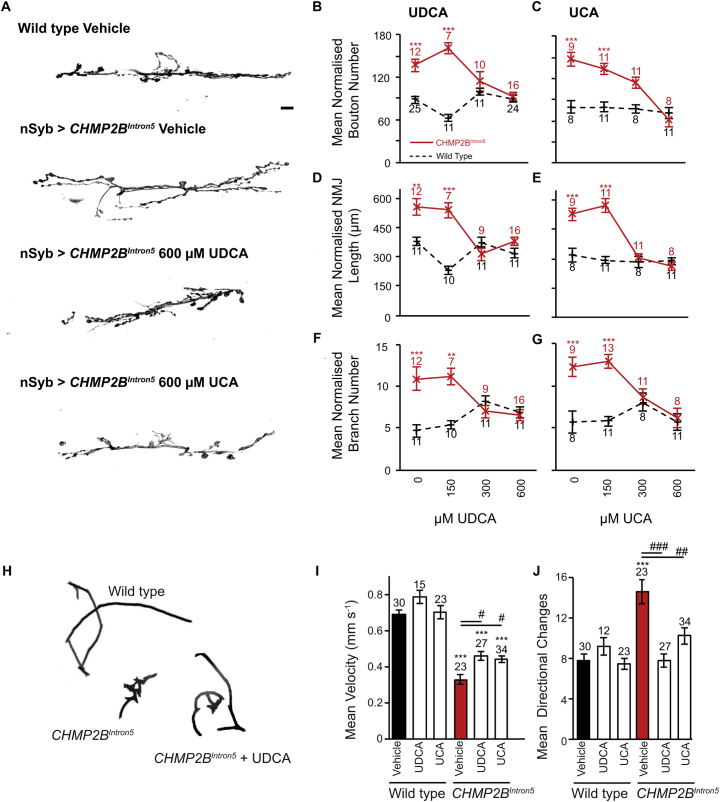
UDCA and UCA Exhibit a Dose Dependent Rescue of Synaptic Overgrowth at the Drosophila NMJ.A. Representative micrographs showing synaptic overgrowth at the Drosophila third instar wandering larval NMJ (Muscle 6/7, hemisegment A3) in larvae pan-neuronally expressing (nSyb-Gal4) UAS-CHMP2BIntron5 administered vehicle, UDCA or UCA. Scale bar = 10 μm.B—C. Quantification of normalised bouton number in wild type (dashed black line) and CHMP2BIntron5 expressing (nSyb-Gal4) (solid red line) 3rd instar larvae in response to increasing doses of UDCA (B) and UCA (C). ANOVA with post-hoc Tukey comparison to vehicle treated (0 μM) control ⁎⁎⁎p < .001.D, E. Quantification of normalised NMJ length in wild type (dashed black line) and CHMP2BIntron5 expressing (nSyb-Gal4) (solid red line) 3rd instar larvae in response to increasing doses of UDCA (D) and UCA (E). ANOVA with post-hoc Tukey comparison to vehicle treated (0 μM) control ⁎⁎p < .01, ⁎⁎⁎p < .001.F, G. Quantification of normalised branch number in wild type (dashed black line) and CHMP2BIntron5 expressing (nSyb-Gal4) (solid red line) 3rd instar larvae in response to increasing doses of UDCA (F) and UCA (G). ANOVA with post-hoc Tukey comparison to vehicle treated (0 μM) control ⁎⁎p < .01, ⁎⁎⁎p < .001.H–J. Addition of UDCA or UCA to Drosophila food alleviates aberrant crawling behaviour in 3rd instar wandering larvae pan-neuronally (nSyb-Gal4) expressing CHMP2BIntron5. H. Representative traces of crawling path. I. Median crawling speed. J. Mean number of directional changes. ANOVA with post-hoc Dunnett's comparison to wild type controls ⁎⁎⁎p < .001 and Tukey comparison between groups #p < .05, ##p < .01, ###p < .001. (For interpretation of the references to colour in this figure legend, the reader is referred to the web version of this article.)